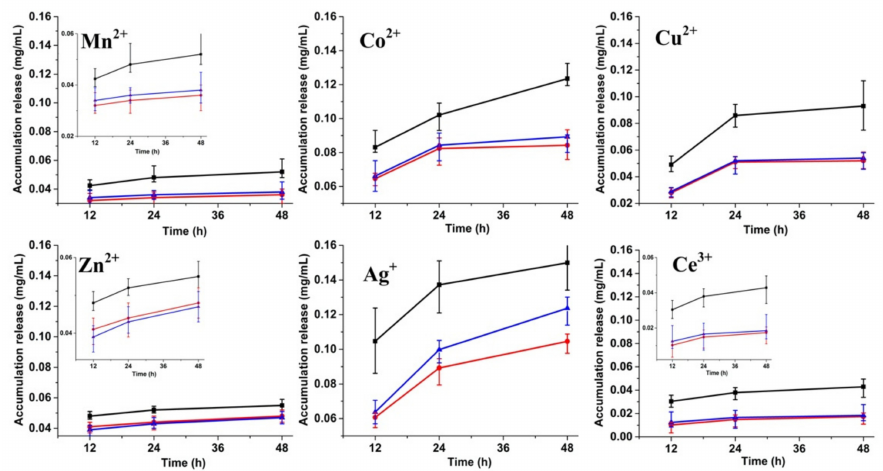
Figure 4. Accumulative release of metal ions from dressing materials at di ff erent pH (pH 5.5: black squares; pH 7.4: red circles, and pH 8.4: blue